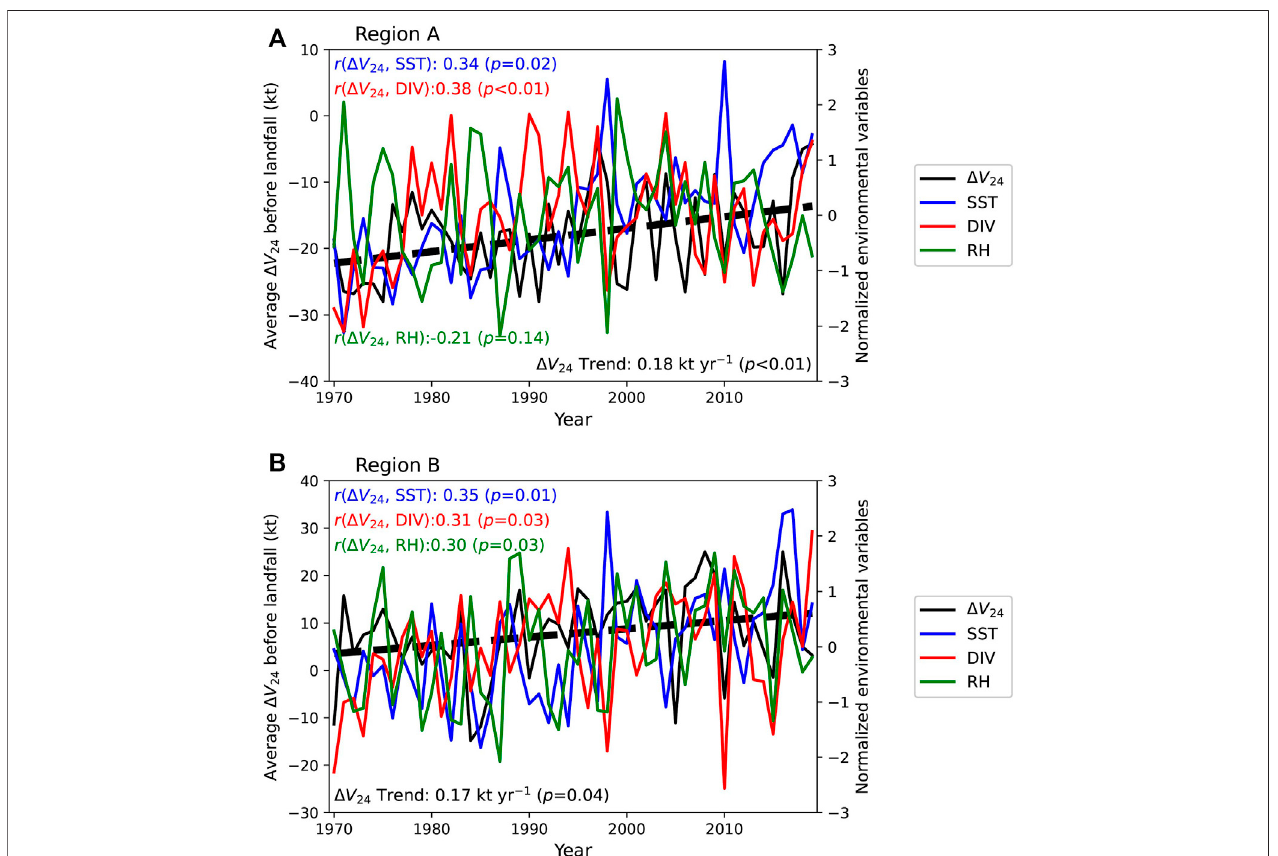
FIGURE 5 | JJASON averages of Δ V 24 before landfall and environmental variables (SST, 700 – 500-hPa relative humidity and 200-hPa divergence) from 1970 to 2019 over (A) Region A and (B) Region B. The black dashed lines denote linear trends in the average Δ V 24 , which are obtained through least squares, while their rates and respective signi fi cance levels are shown in the